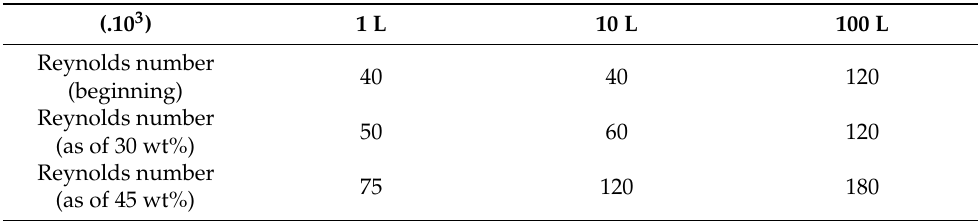
Table 3. Overview of the Reynolds number for the different reactor sizes.